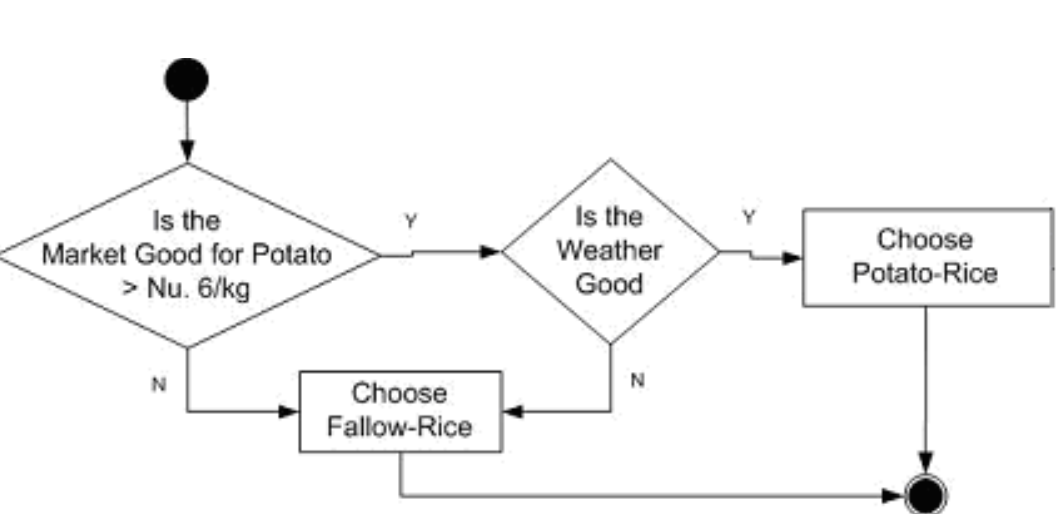
Fig. A2.1. Process for deciding on a cropping pattern in the Limbukha model. The dark dot represents the start of the process, the circled dot the end of the